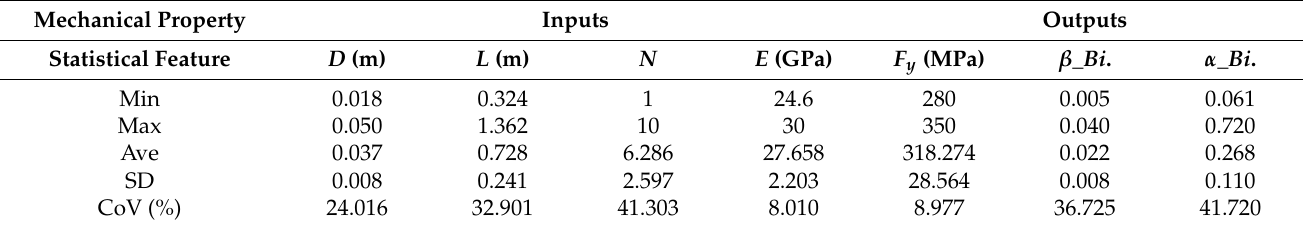
Table 2. Statistical properties of the numerical